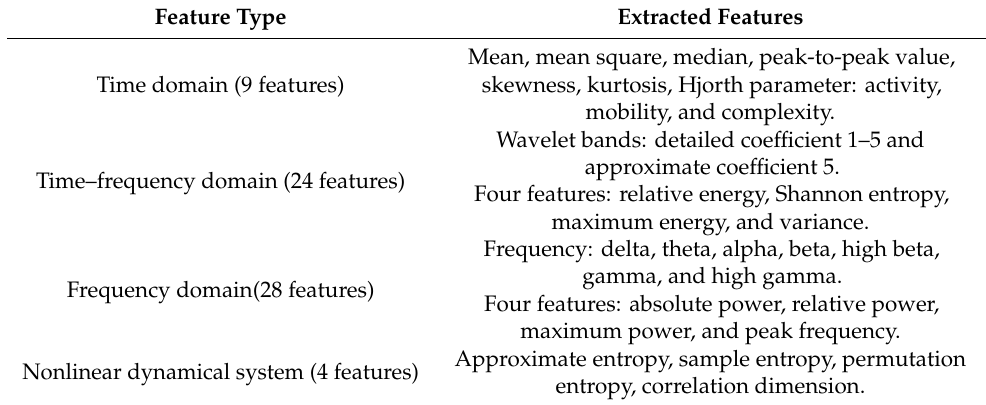
Table 2. Extracted electroencephalography (EEG) features in the four main